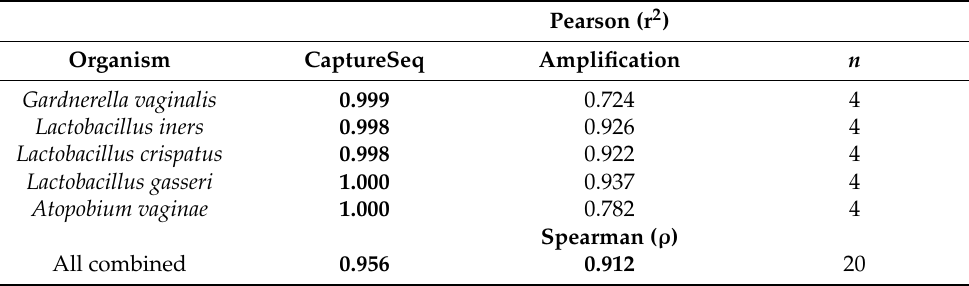
Table 3. Correlations between cpn60 gene copies determined by species-specific quantitative PCR and the number of sequencing reads mapping to each taxonomic cluster by CaptureSeq or amplification for 5 bacteria from a synthetic community spiked into a background of wheat seed washes. Samples were spiked at 4 levels (high, medium, low, unspiked) using cpn60 plasmids from bacteria exogenous to the seed washes and quantified using qPCR and by read numbers determined from CaptureSeq and marker amplification. Significant correlations ( p < 0.01) are shown in